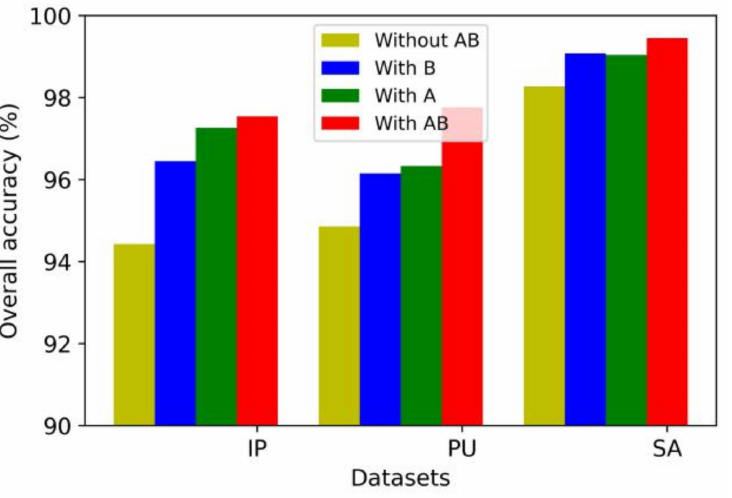
Figure 12. Effectiveness of multiscale